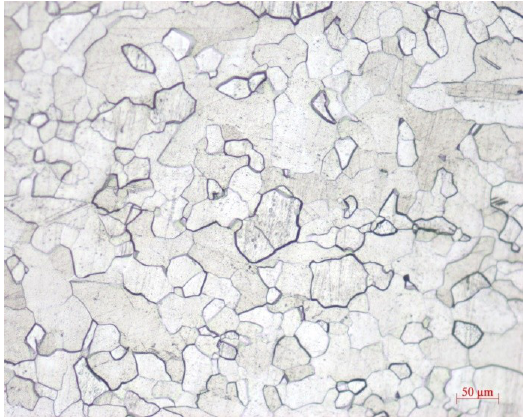
Figure 3. Optical micrograph of CP-Ti. Table 3. Scheme of Fatigue Crack Growth (FCG) tests of CP-Ti under different load ratios and temperatures.